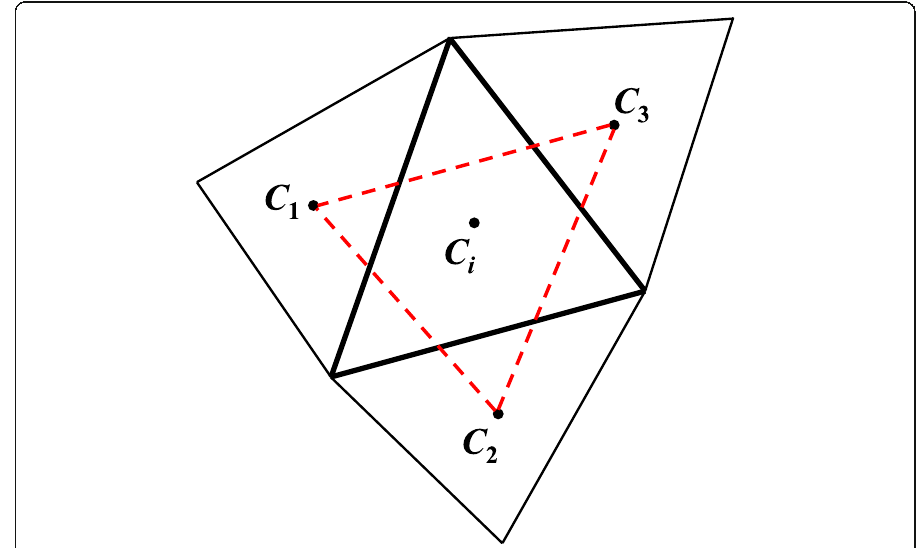
Fig. 2 Diagram of reconstructed triangular stencil